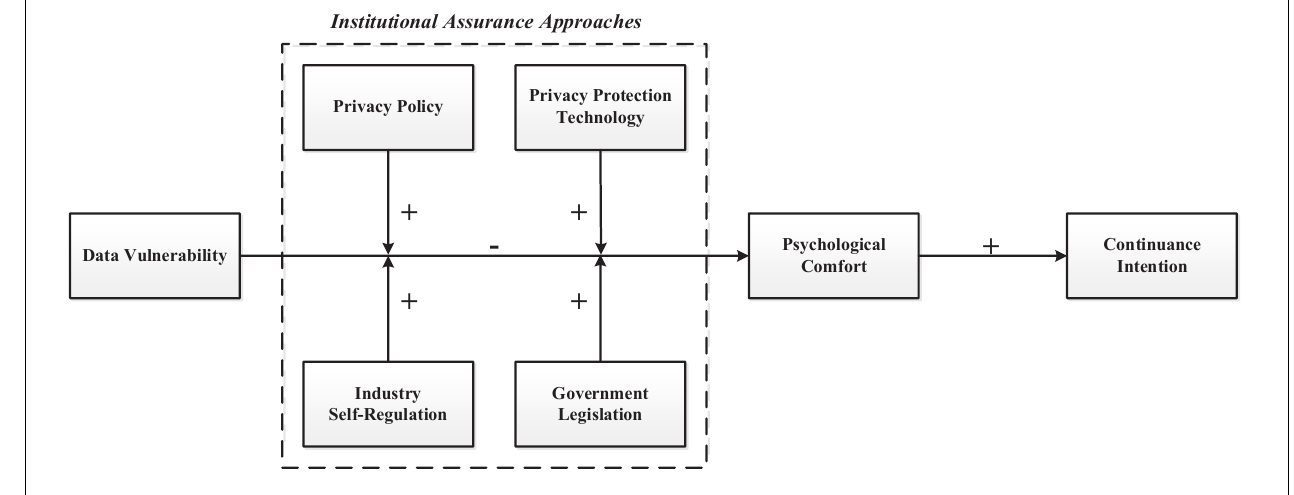
FIGURE 1 | Conceptual